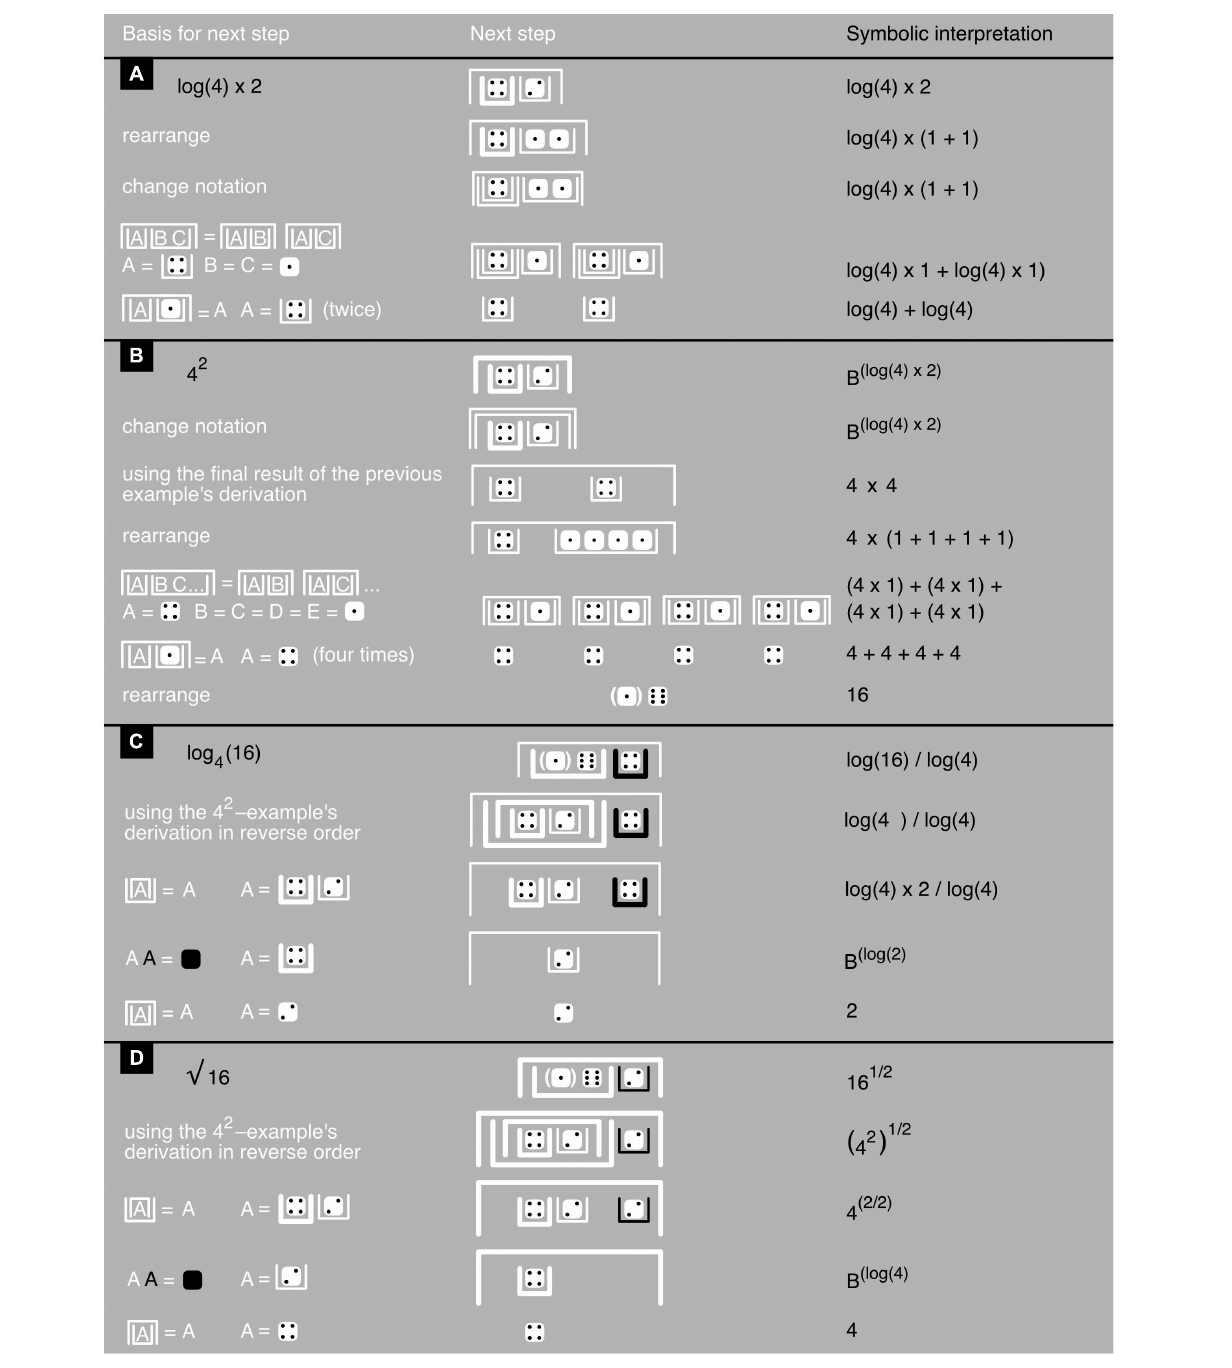
FIGURE 9 | Iconic exponentiation and taking iconic logarithms and roots. (A–D) Show examples with, based on Figure 7 axioms and theorems, the justification of each next step toward a problem’s solution (left), the step itself (middle), and a symbolic interpretation (right). In the first example, the logarithm’s base has been left unspecified and the final result cannot be computed. In the third, a base has been specified in the symbolic version, and a base-free equivalent of it in the iconic version; now the final result can be